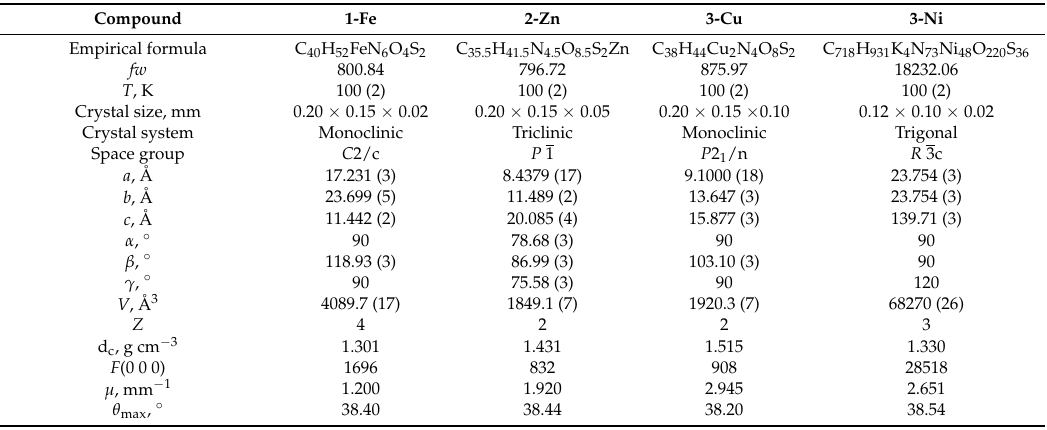
Table 1. General crystallographic information on complexes